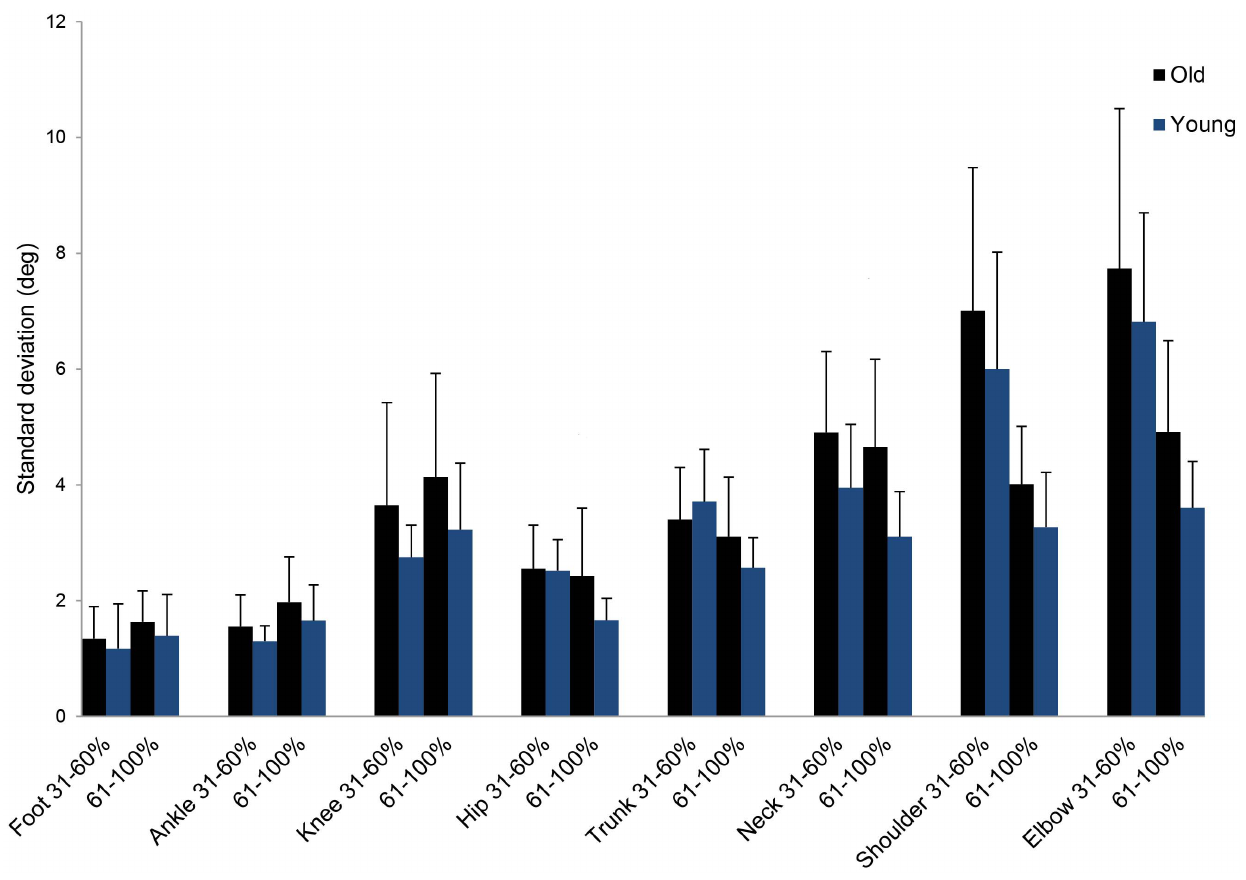
Figure 4. Standard deviation of joint position data in old and young participants. Across trial standard deviations for old and young adults of the foot, ankle, knee, hip, trunk, neck, shoulder and elbow joint in degrees during lift-off (31–60%) and the extension phase (61–100%) of the sit-to- stand task. Error bars represent standard error of the mean. Asterisk indicates significant difference between age groups (*=p , .05, **=p , .01).